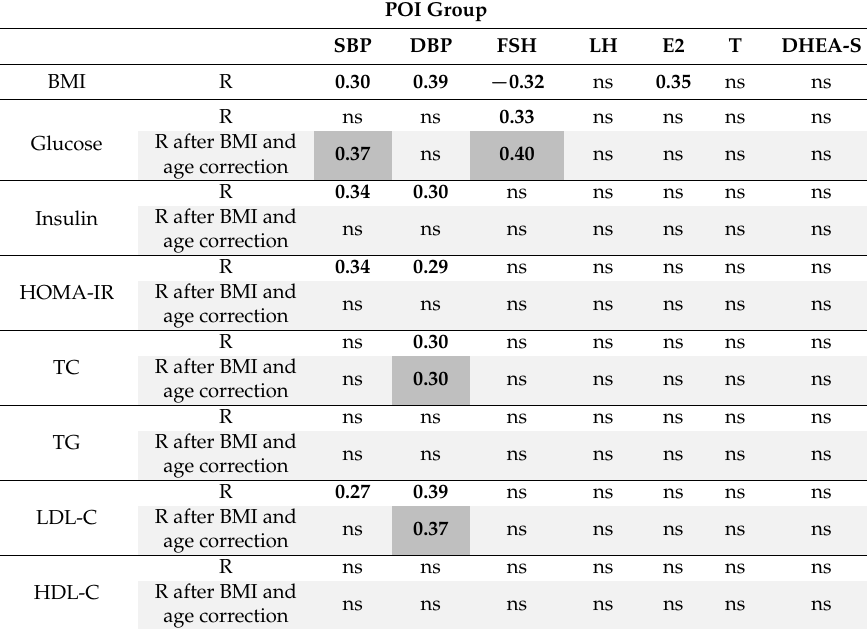
Correlations between hormone and metabolic parameters of POI patients.